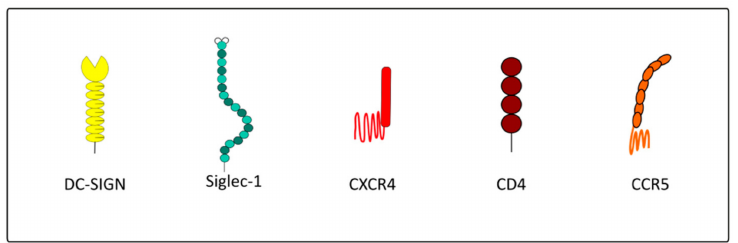
Figure 4. Model for role of the macrophage in cell-cell HIV-1 dissemination. Macrophages can become infected through di ff erent mechanisms, and participate in HIV-1 dissemination within the host. ( 1 ) HIV-infected cells form intercellular bridges—TNT—structures hijacked by the virus to spread from one cell to another, tra ffi cking on the inside or outside of the structure, possibly by selective use of attachment receptors (e.g., Siglec-1, DC-SIGN). ( 2 ) Macrophages fuse with acutely infected CD4 + T cells, leading to a viable, infected heterokaryon. ( 3 ) As professional phagocytes, macrophages recognize infected and dying CD4 + T cells. Release of viral particles from the T cell during capture and phagocytosis allows high multiplicity macrophage infection. ( 4 ) In infected macrophages, the virus buds into a specialized virus-containing compartment (VCC). Upon encounter with CD4 + target T cells, VCC containing either free virions or attachment receptor-bound viral particles release virions that infect the target